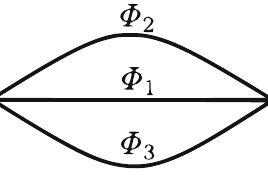
Fig. 1 Diagrammatic representation of the coupling (20) up to order g 2